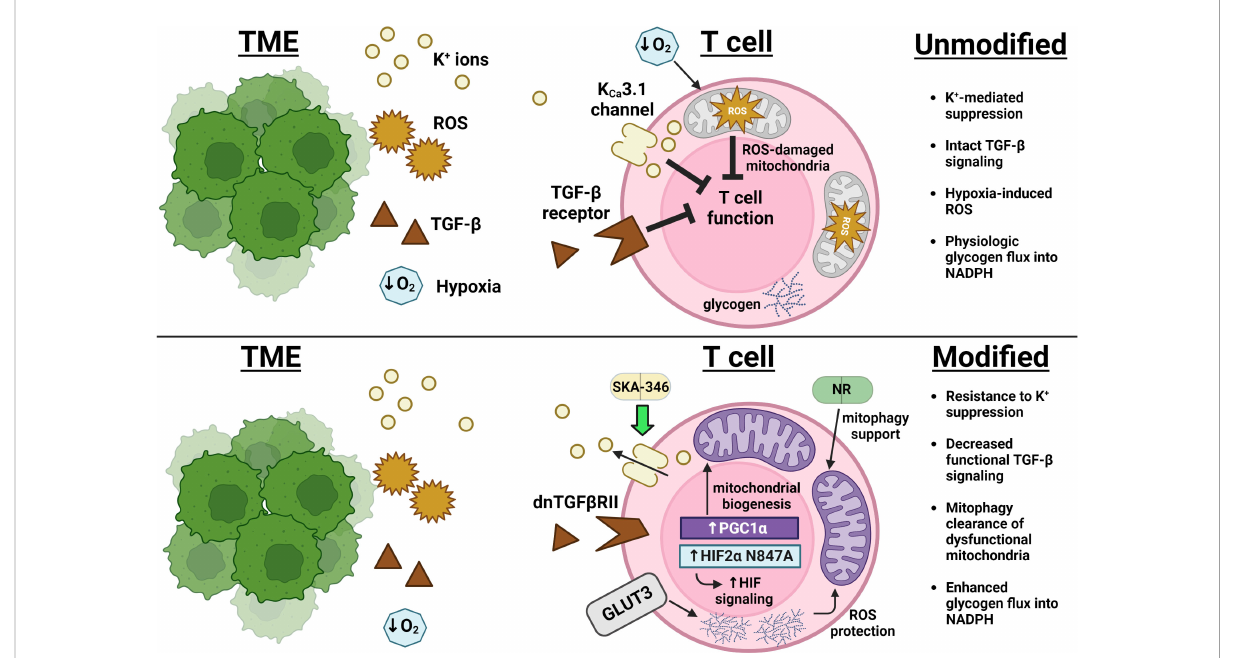
FIGURE 1 Advances in overcoming immunosuppression and impingement on metabolism in the TME. Excess extracellular potassium (yellow) limits nutrient uptake concomitant with and critical for T cell effector function (49). The K Ca 3.1 channel activator SKA-346 facilitates extrusion of this potassium to restore production of cytotoxic molecules (50). Expression of a TGF- b receptor mutant that can bind TGF- b but cannot activate SMAD decreases transduction of the broad immunosuppressive signals (brown) downstream of this pathway (36, 37). Overexpression of PGC1 a leads to an increase in mitochondrial mass (purple), while overexpression of GLUT3 (gray) supports glucose uptake that fuels glycogen storage, protecting T cells from ROS (orange) encountered both as part of the TME and as a consequence of mitochondrial metabolism (63, 64). Supplementation with nicotinamide ribose (NR) enforces mitophagy of ROS-damaged mitochondria and improves overall mitochondrial fi tness (65). Expression of a HIF2 a mutant resistant to Factor Inhibiting HIF (FIH)-mediated suppression enhanced T cell responsiveness in the hypoxic TME (blue)